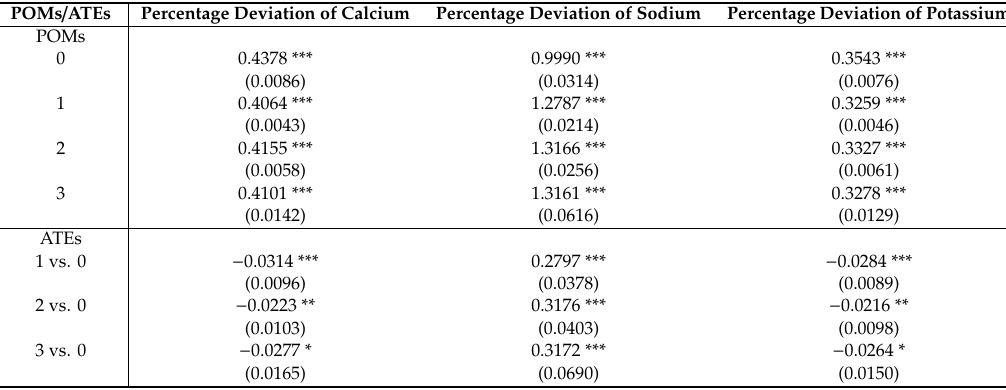
Table 7. The average treatment e ff ects on macrominerals